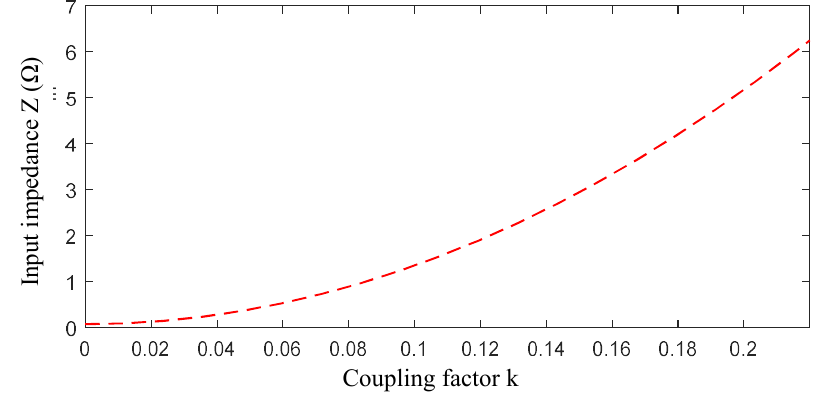
Figure 9. Input impedance Z in vs. coupling factor k .